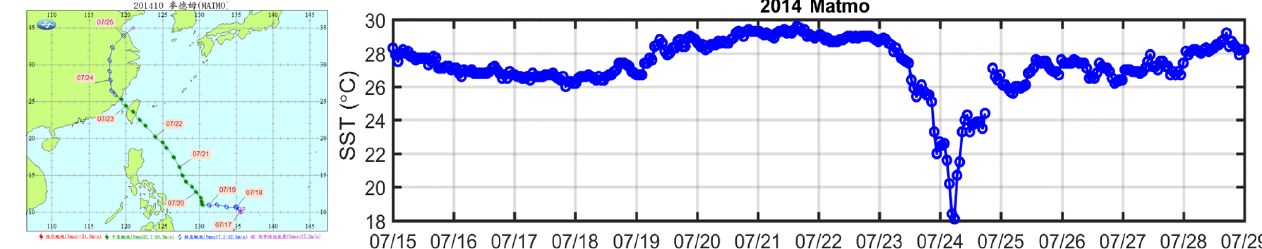
Figure A5. (5) Typhoon Matmo in 2014, max (cid:49) SST = 10.4 ◦ C.